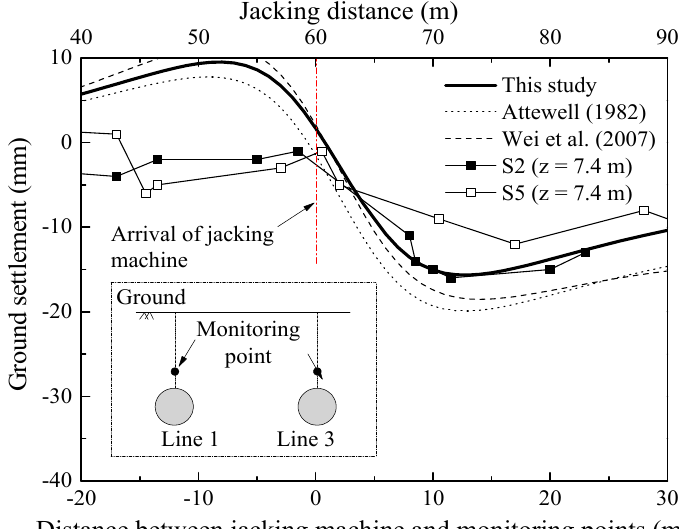
Figure 12. Ground settlements at depth of 7.4 m below surface.